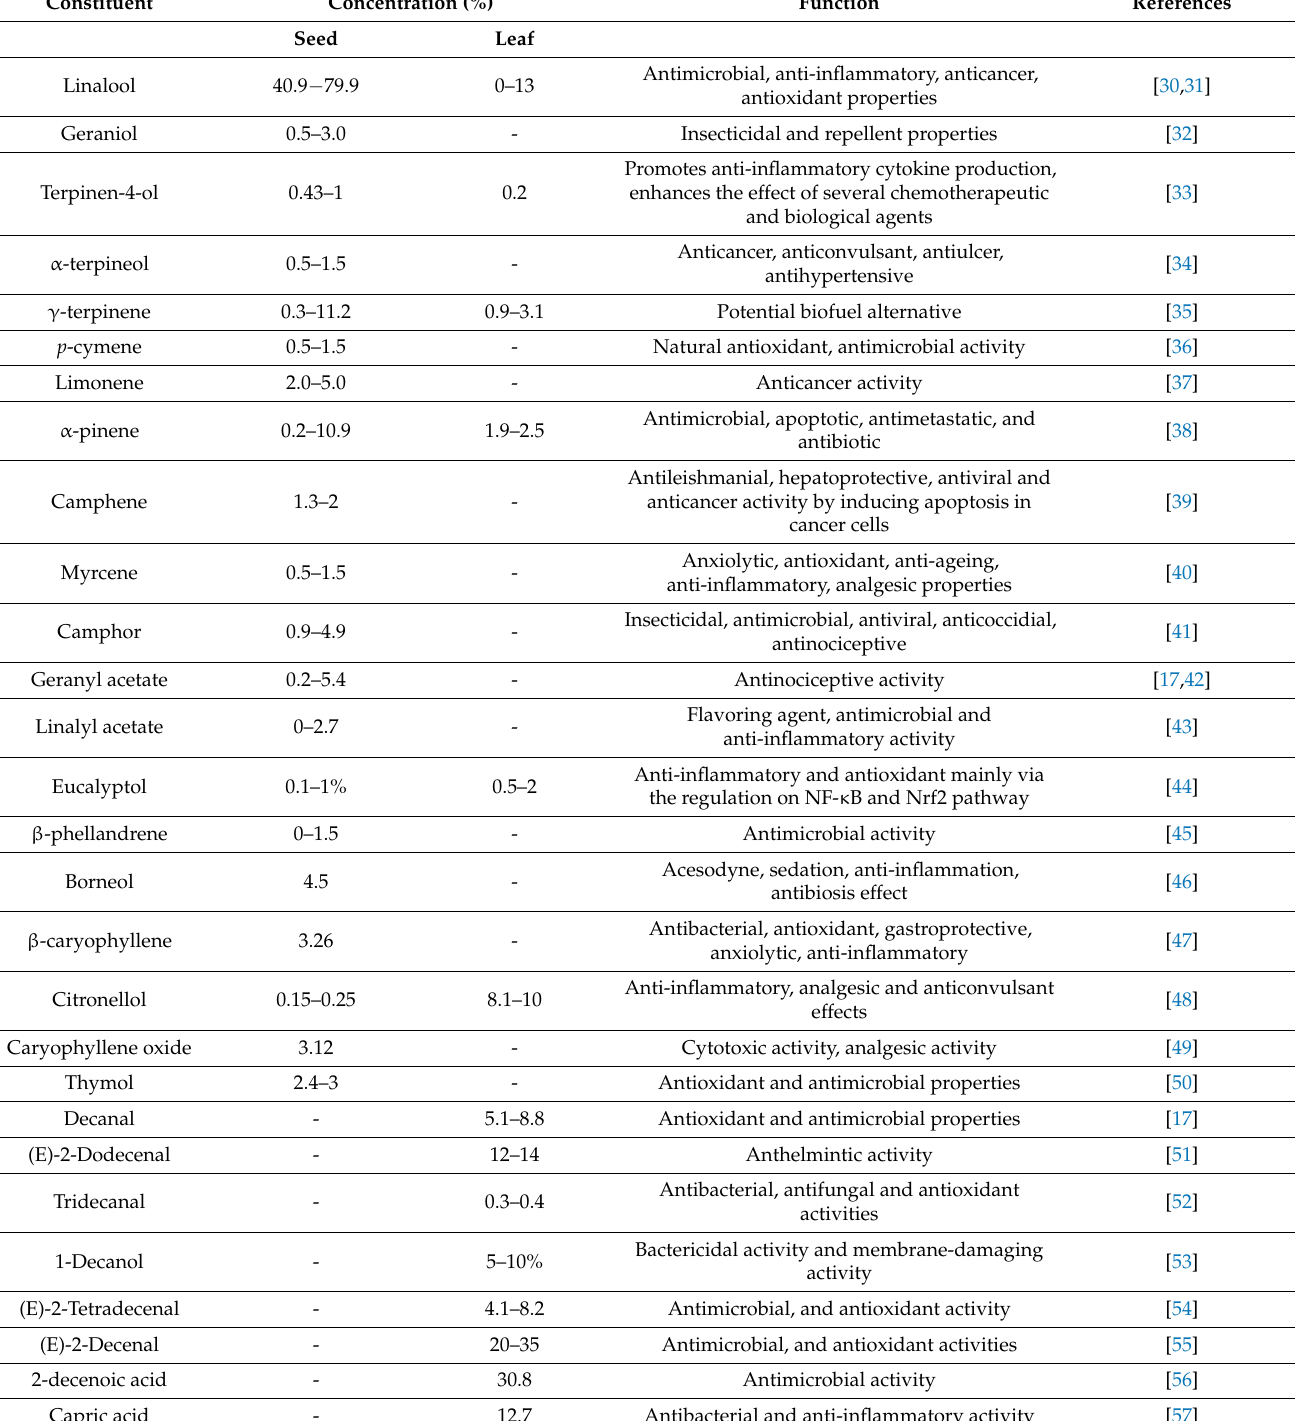
Table 2. Chemical composition of coriander seed and leaf oil along with its biological